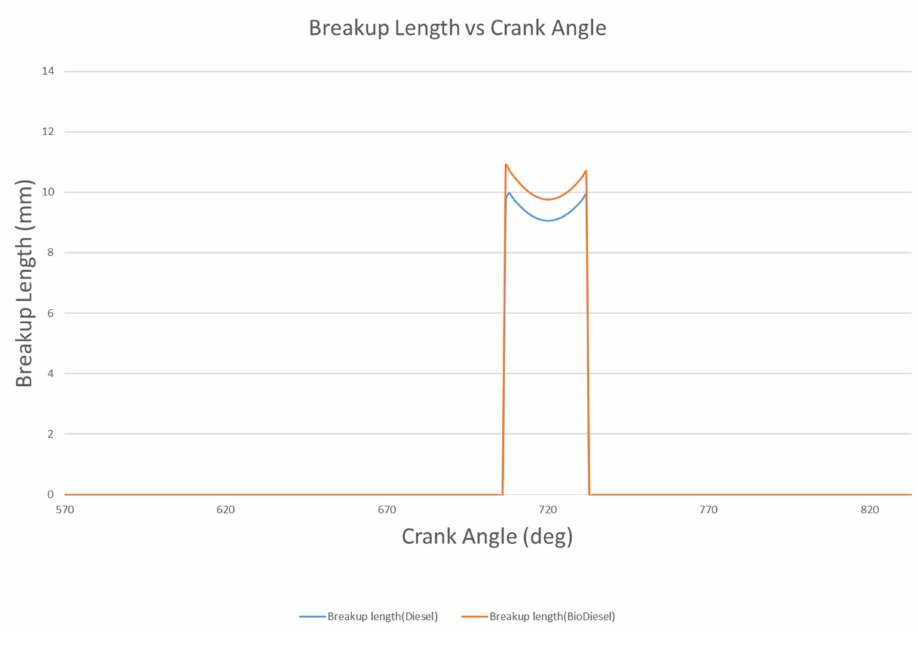
Figure 8. Breakup length vs. crank angle.